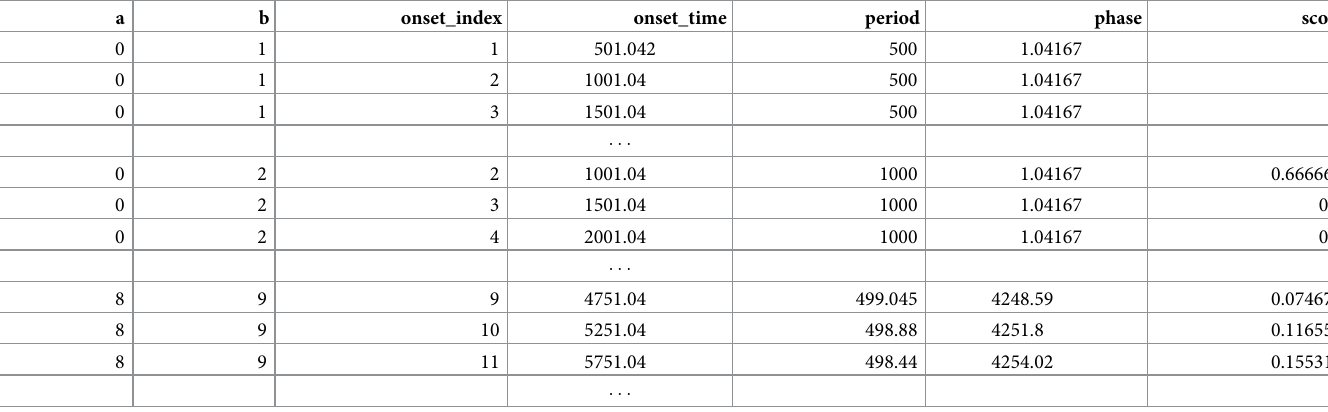
Table 1. Example rows of the table output of the THT model.